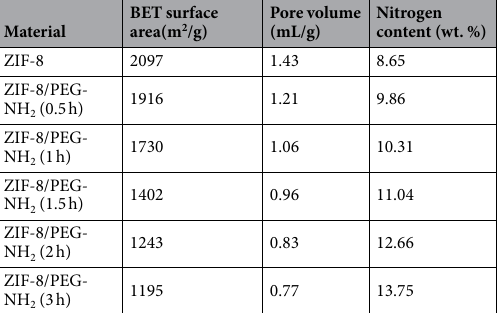
Table 1. Surface area, pore volume and nitrogen content of the virgin ZIF-8 and ZIF-8/PEG-NH 2